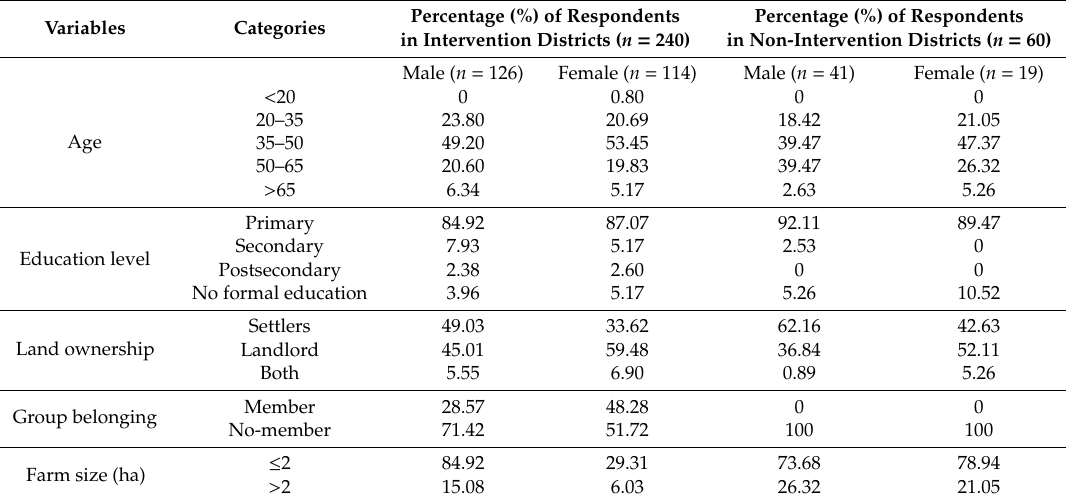
Table 2. Characteristics of interviewed groundnut farmers ( n =